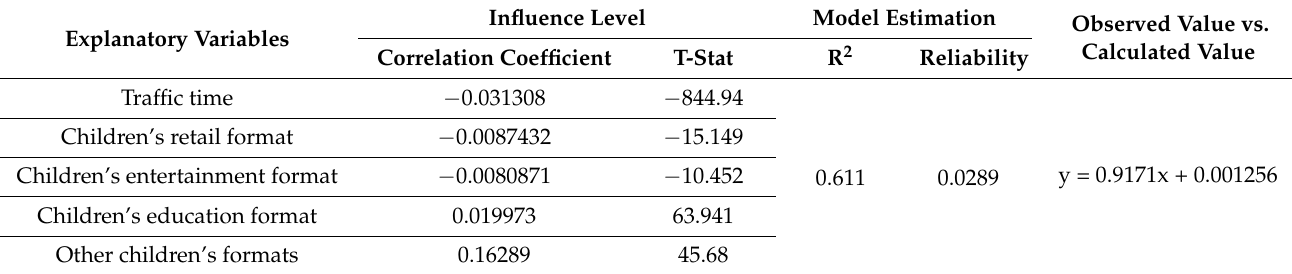
Table 3. Modeling results for commercial centers of all levels.